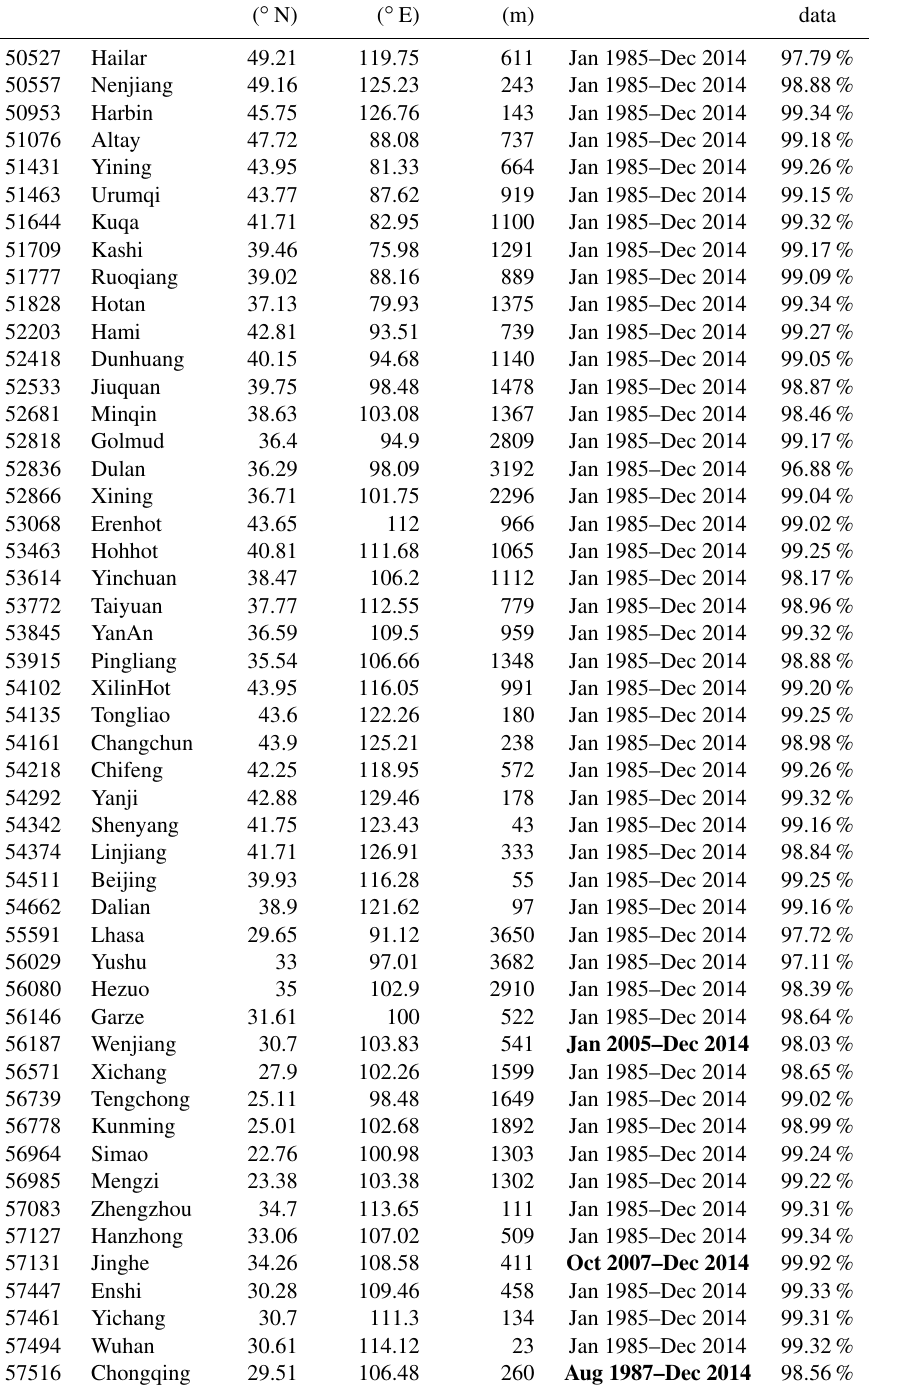
Table A1. The information of 66 stations used in this study. Date ranges are the periods when radiosonde data, daily precipitation, and daily maximum temperature are all available at the same time. The periods less than 30 years are highlighted in bold. The percentages of valid data are presented. Data periods of less than 30 years are highlighted in